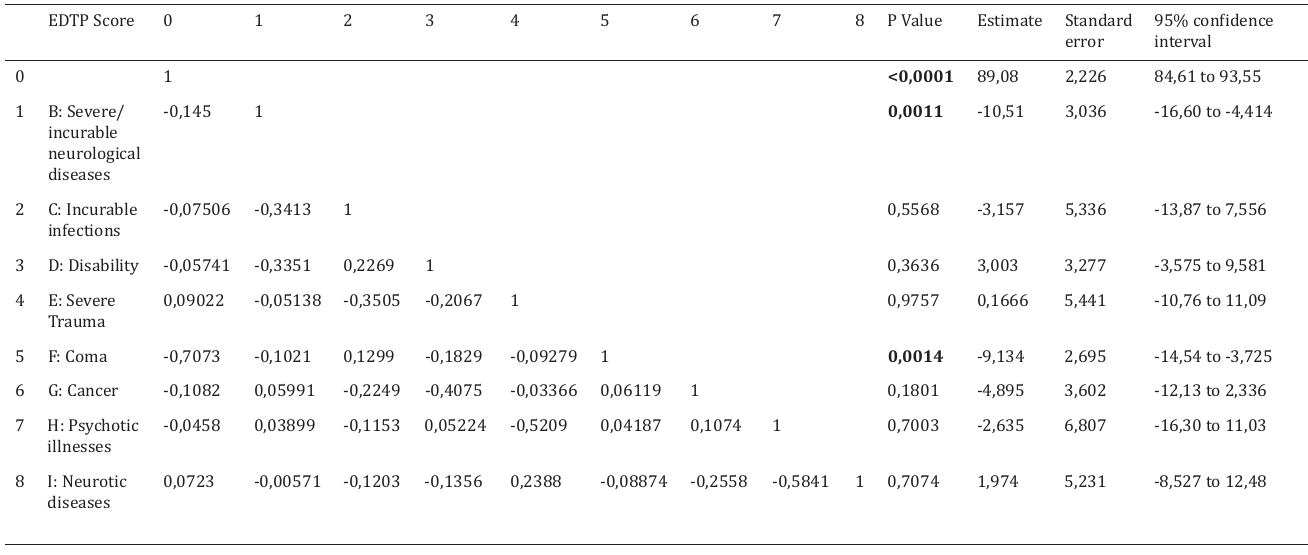
MANOVA of disease groups according to attitude scale towards euthanasia, death, and the terminally